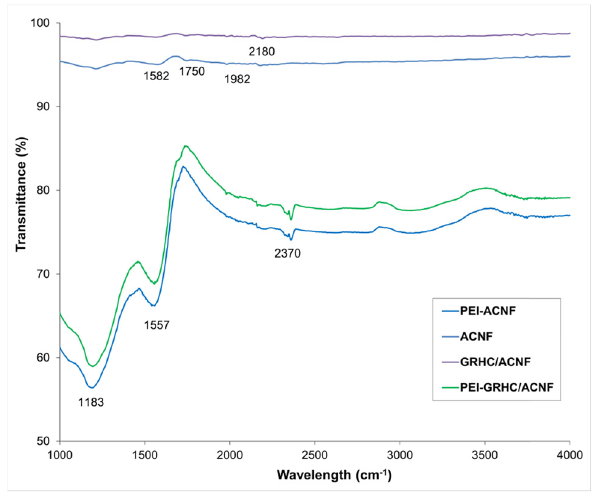
Figure 7: FTIR spectrum of PEI - impregnated and nonimpregnated ACNFs and